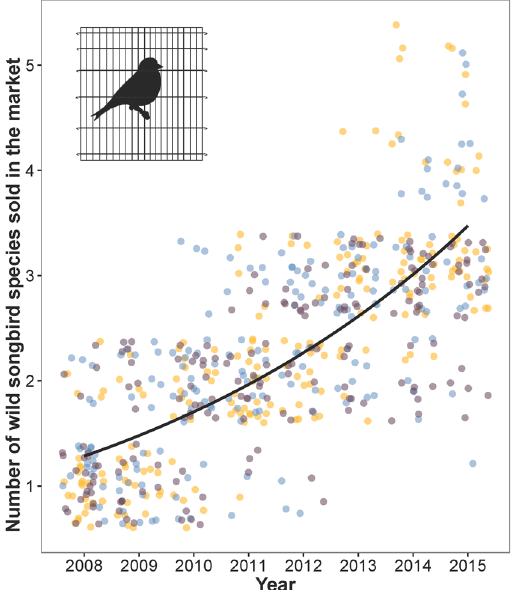
Figure 7. Changes in the number of wild species of songbirds regularly sold in the market between 2008 and 2016. The points were jittered to avoid overlap. Here, exotic species were not included. The fitted line is a Poisson regression (averaged across provinces). Colors refer to provinces; blue: Annaba, orange: Guelma and, brown: